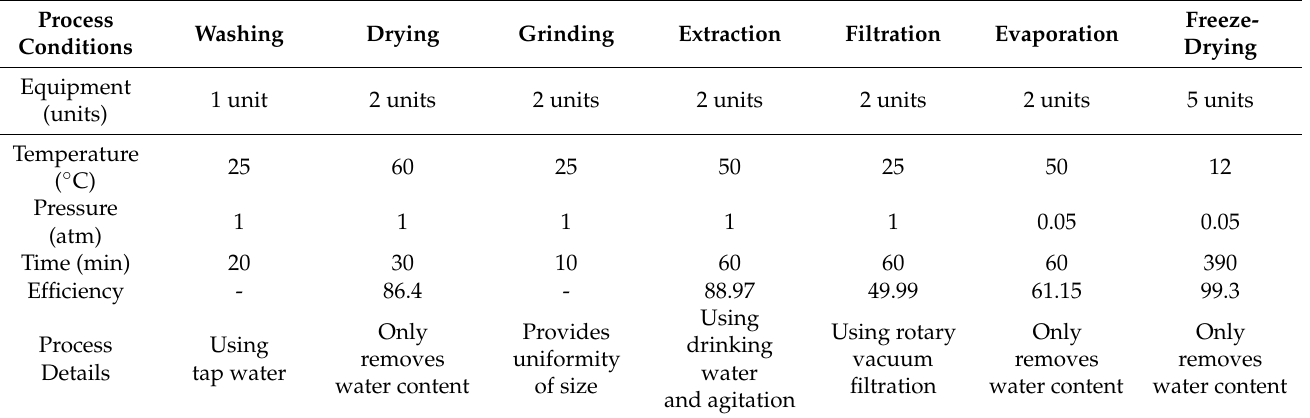
Table 3. Overall process condition